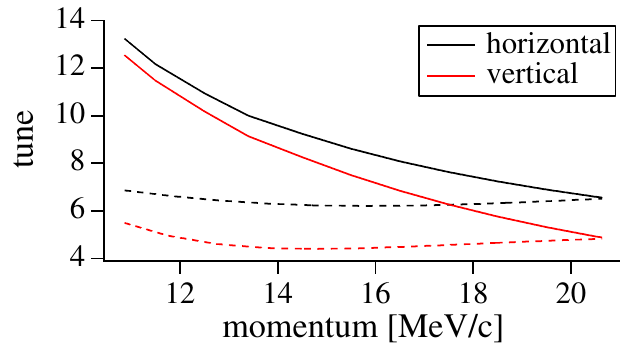
FIG. 8. Example of single particle normalized amplitude evo- lution when alignment errors are included. It takes 1000 turns to finish the whole cycle. As Fig. 6 indicates, the vertical tune starts from around 5.5 and goes to the tune of around 4.3. Then, it increases